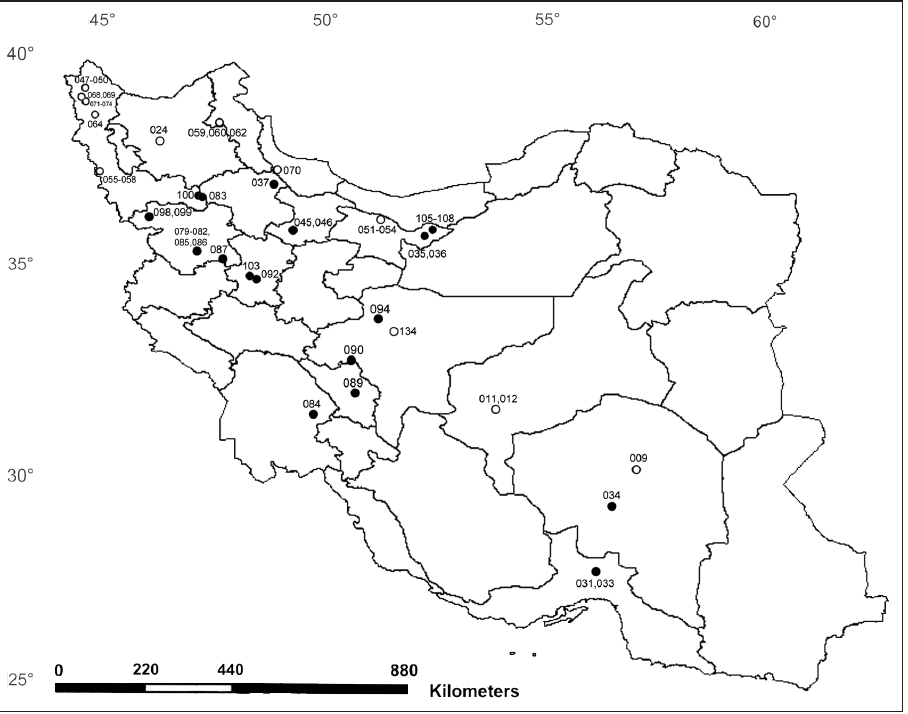
Figure 9. Distribution map of sequenced specimens of Stenus callidus (  ) and S. erythrocnemus (  ). Numbers are haplotype numbers (see Table 4). Sites with more than one haplotype number indicate several geographically close